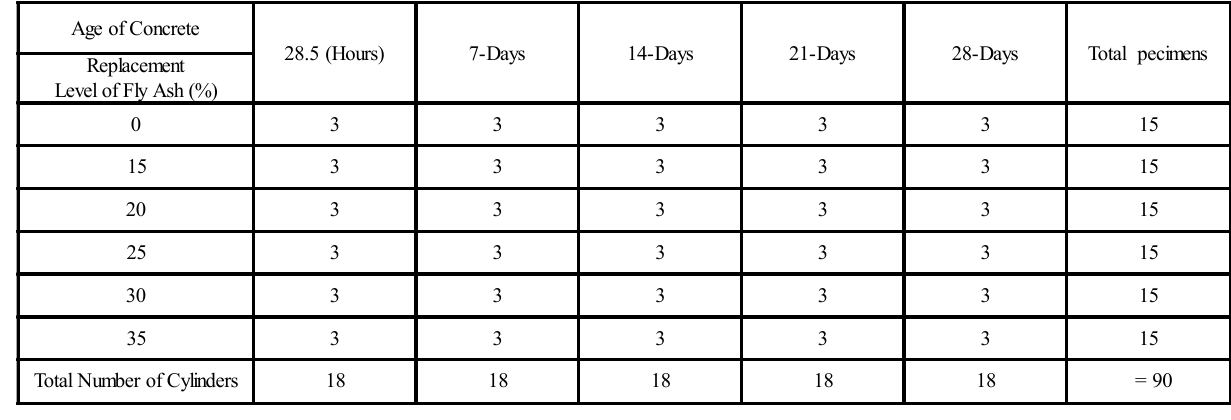
FIG. 1. CARRYING OUT COMPRESSION TABLE 1. DETAIL OF CYLINDER SPECIMENS